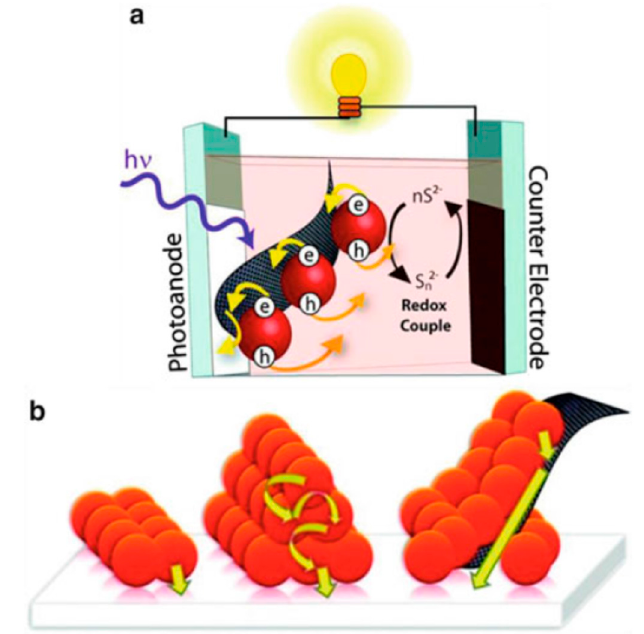
Figure 12. ( a ) Structure of QDSSCs based on graphene/CdSe QDs photoanode and ( b ) schematic of a photoanode that has graphene/CdSe QDs absorbing on the FTO substrate.